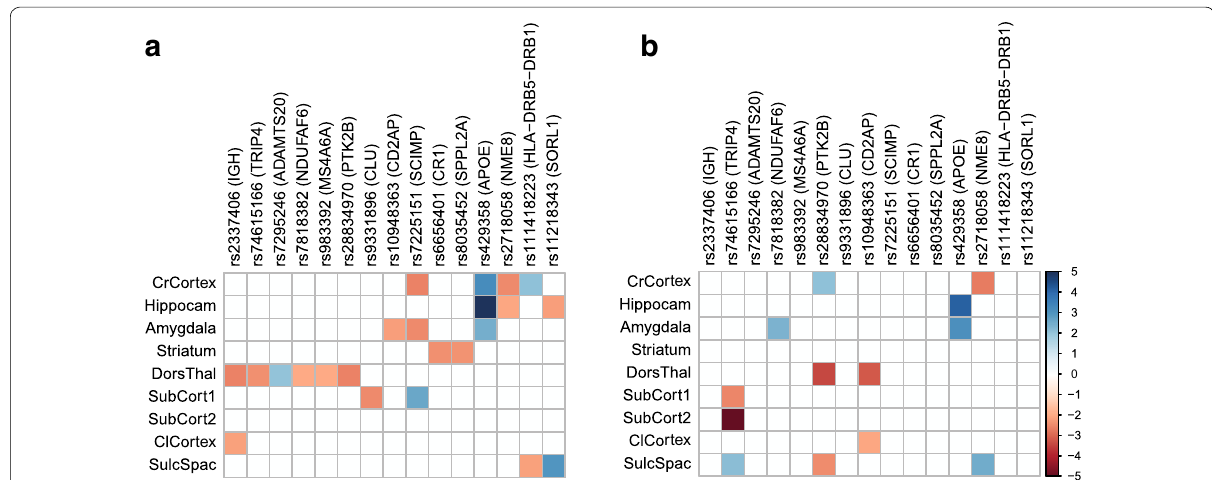
Fig. 4 Association between SNPs and latent variable scores, as found by the robust maximum likelihood fit of the SEM. All nominally significant associations ( p < 0.05 ) are coloured by their robust z -statistic values [23]. The linked genes [25] are shown in brackets. a The results for the training set. After Bonferroni correction for the 315 tests, only the effect of rs429358 ( APOE ) on the hippocampus region group remains significant. b The